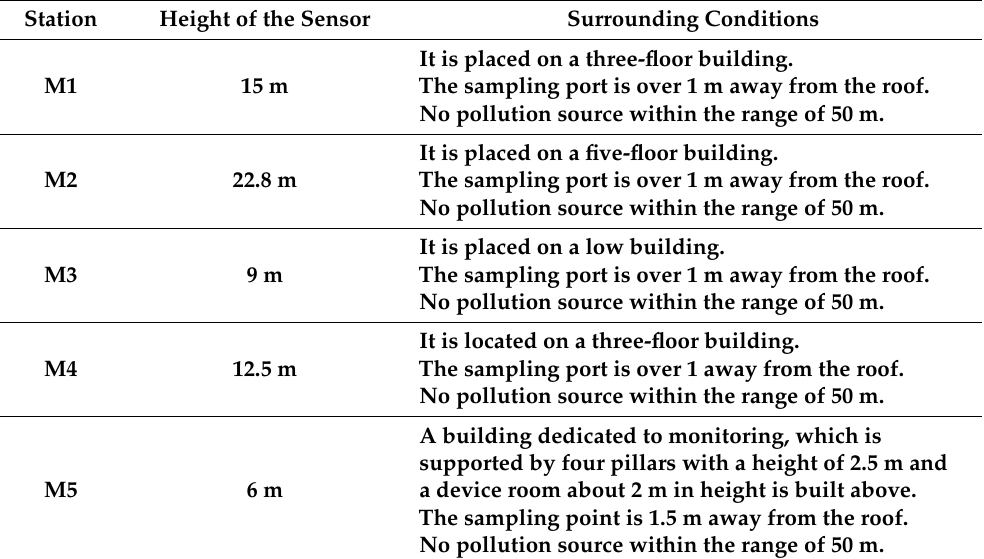
Table 1. Conditions of each monitoring